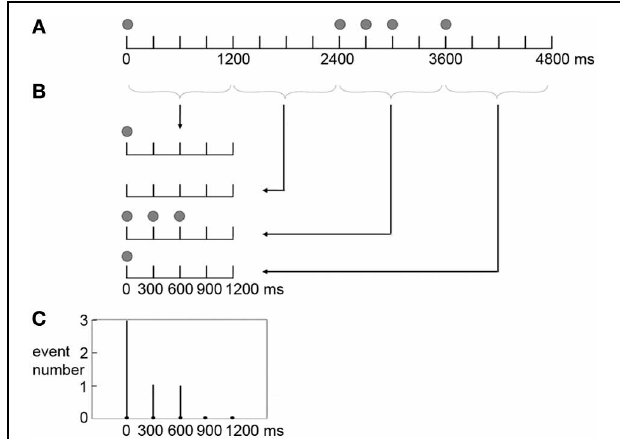
FIGURE 3 | Scheme of producing the frequency distribution of presented events in a beat interval. Shown is the calculation for a sample rhythm 8-1-1-2-4. (A) The five events (indicated by filled circles) occur at 0, 2400, 2700, 3000, 3600ms in a measure. (B) In terms of individual beat intervals, events occur at 0ms in the 1st beat interval; 0, 300, and 600ms in the 3rd beat interval; and 0ms in the 4th beat interval. (C) Event occurrences in individual beat intervals are added up, resulting in 3 event occurrences at 0ms, 1 event occurrence at 300ms, and 1 event occurrence at 600ms within a beat